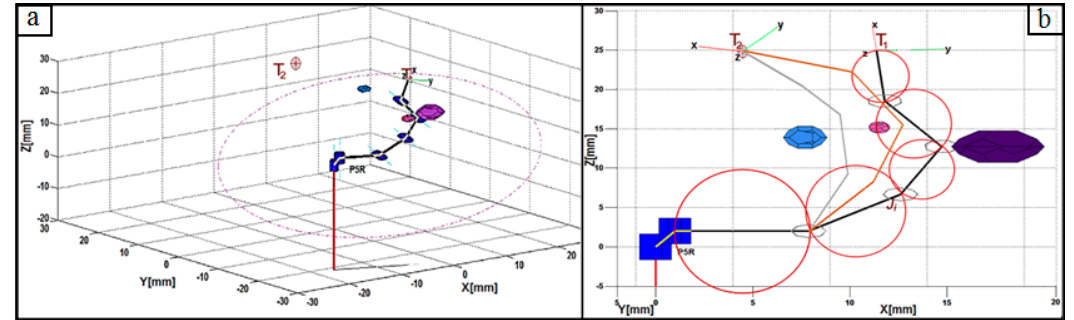
Figure 5. Analysis of the IK solution for obstacle ( a ) detection and ( b ) avoidance during motion